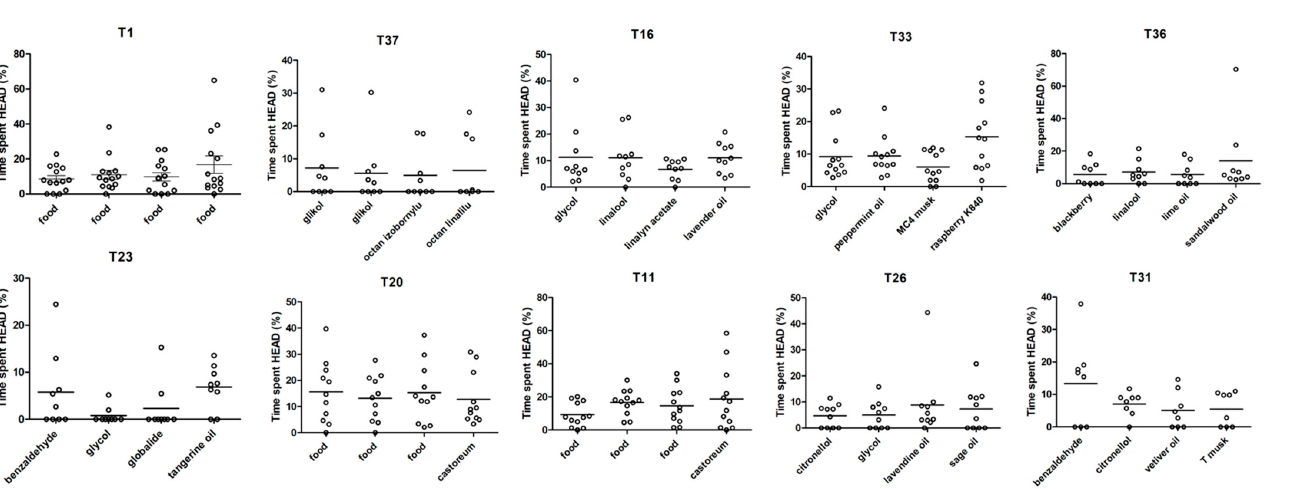
8 of 18 Figure 2. Percentage of time spent by the dog with its head within handler vs. sample areas. Percentage of time spent by the dog with its head within the handler vs. the samples area in each trial. Differences were statistically significant in all trials, except for trials 1, 11, 16, 20, 23, 26, 31, 36, and 37, in which the difference between time spent with handler vs. time spent with samples was not significant.